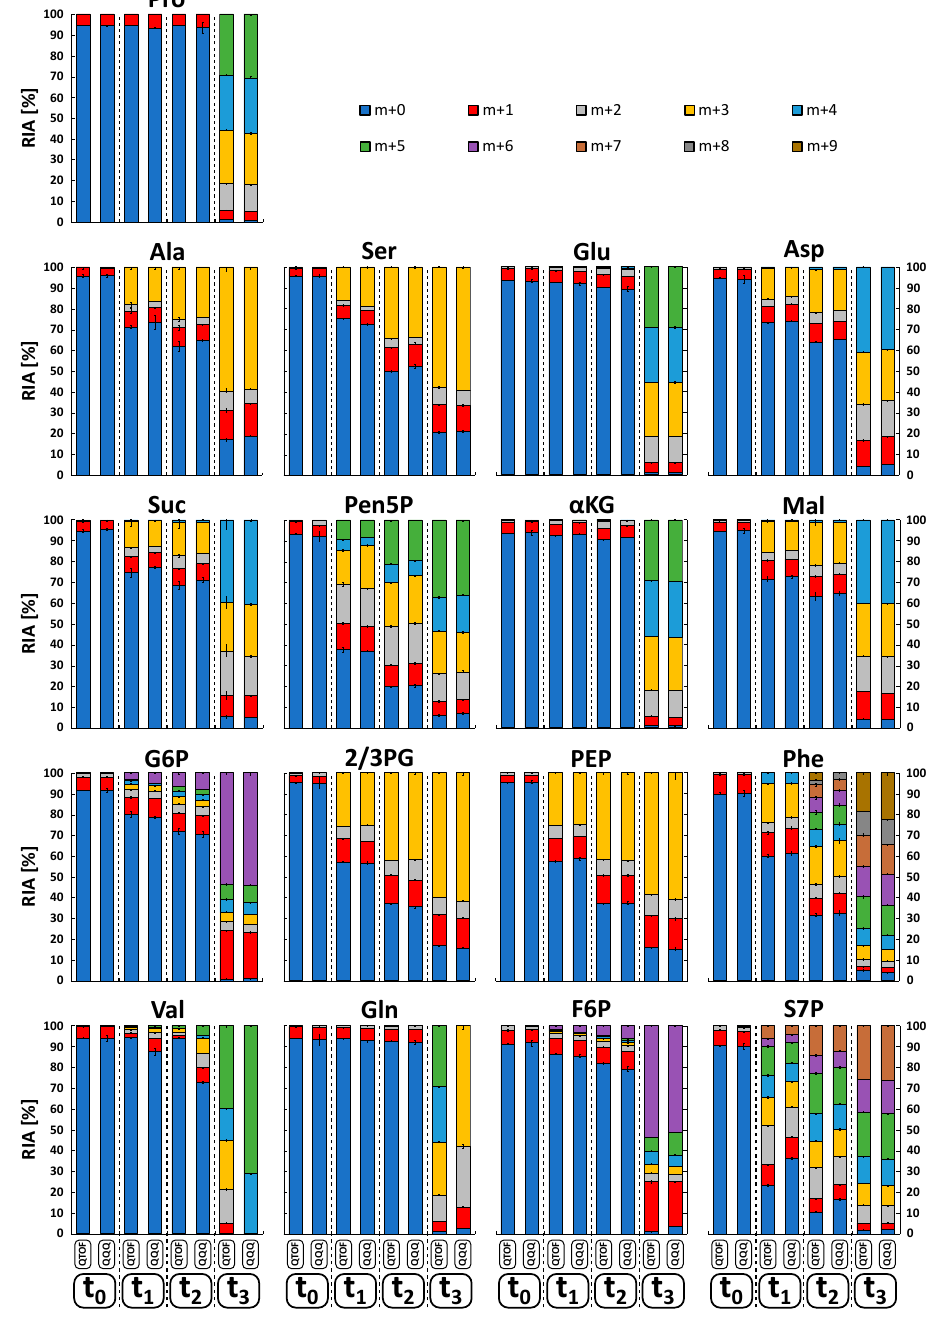
Figure 5. Relative isotopologue abundances (RIA) of selected metabolites. Based on dynamically 13 C- labeled C. glutamicum metabolite extracts (t 0 < 0 sec, t 1 = 28 sec, t 2 = 52 sec, t 3 = 10 h), analyzed by QTOF- HRMS and QQQ-SIM ( n = 5). See Table S1–4 for the full names of abbreviated metabolites.